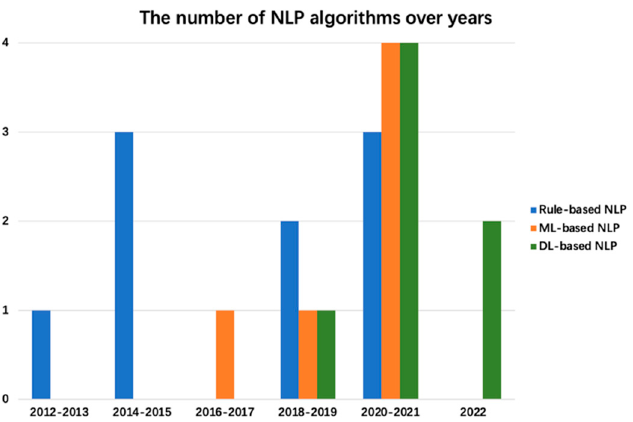
Figure 5. The number of NLP algorithms over the years (2012–2022): a comparison of rule-based NLP algorithms, ML-based NLP algorithms, and DL-based NLP algorithms. NLP algorithms, ML-based NLP algorithms, and DL-based NLP